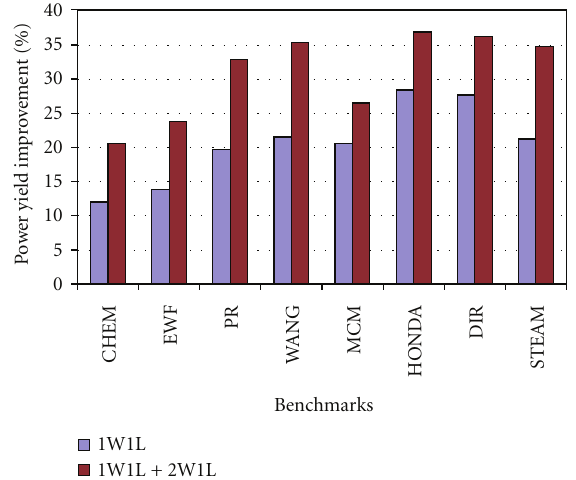
Figure 16: Power yield improvement against deterministic worst- case approach with asynchronous level conversion and di ff erent timing yield